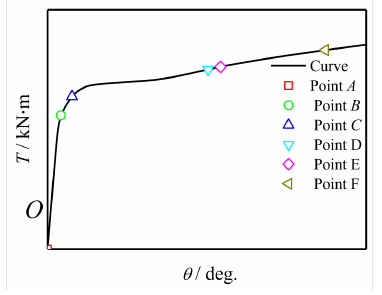
Figure 14. Typical T- θ curve of